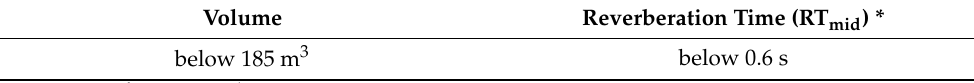
Table 12. Proposed reverberation time standard for Korean lower-grade elementary school classrooms.